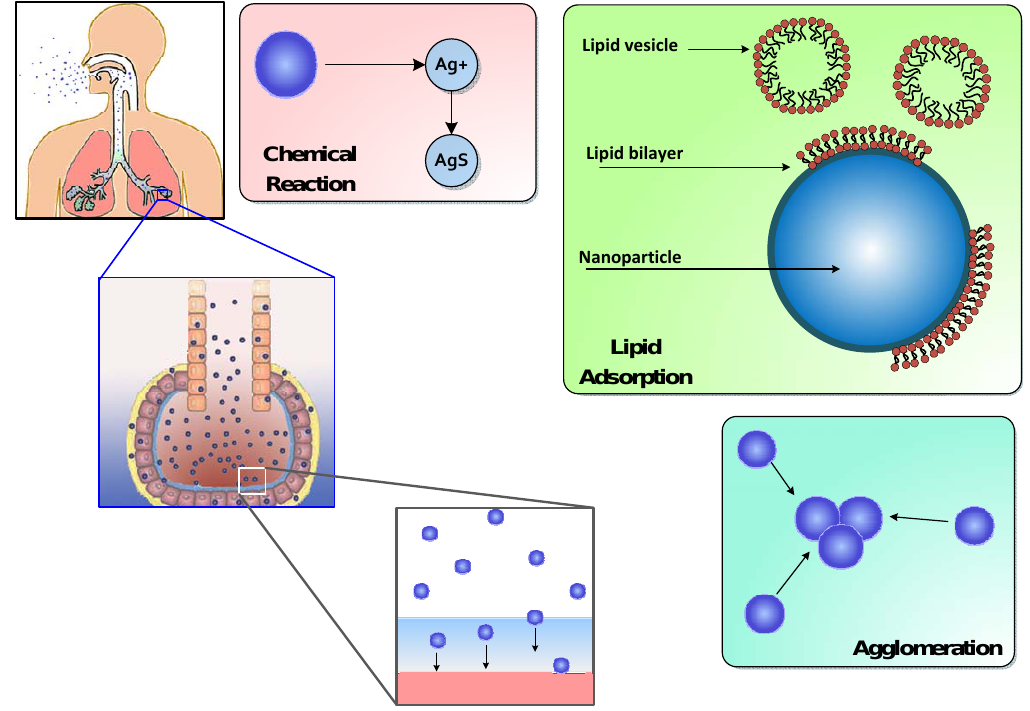
Figure 1. Schematic representation of salient processes and mechanisms of transport, transformation and interaction of inhaled engineered nanomaterials (ENMs) in the pulmonary alveolar lining layer (diagram not to